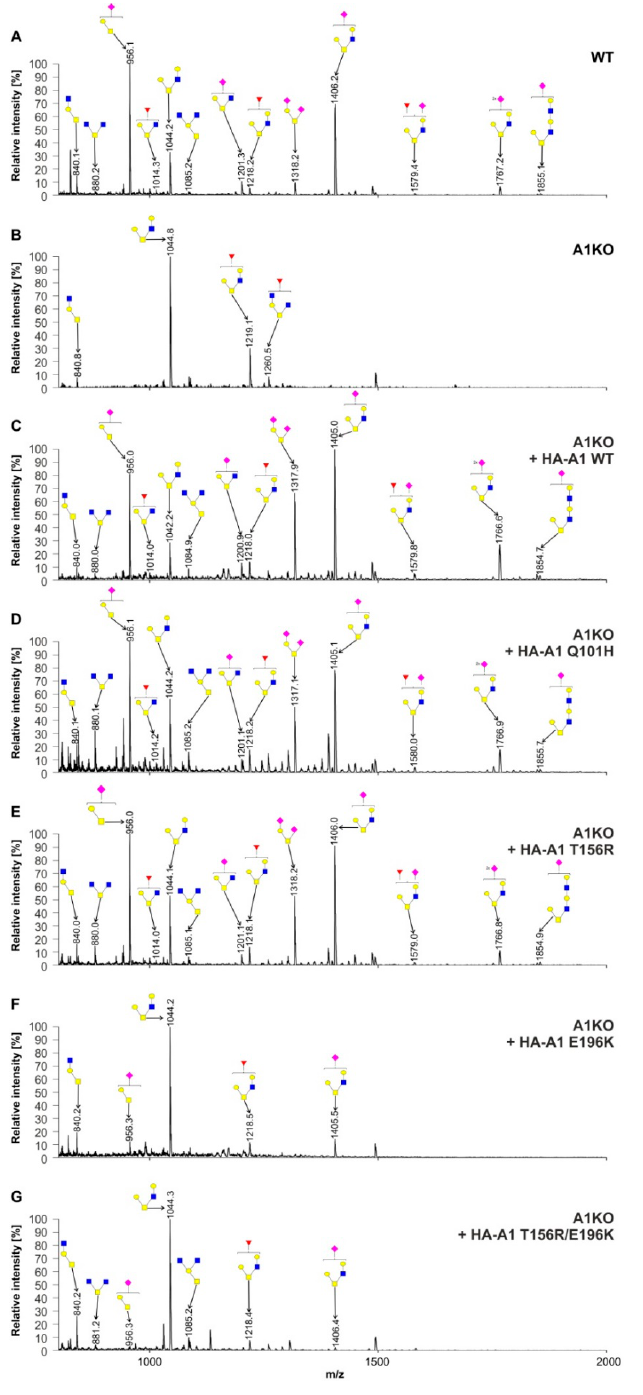
Figure 8. Structural analysis of O-glycans. MALDI-TOF MS characterization of permethylated Bn-O-glycans secreted to culture medium by the wild-type HEK293T cells (WT) ( A ), CST-deficient cells ( B ), CST-deficient cells expressing wild-type CST ( C ), CST-deficient cells expressing the Q101H CST variant ( D ), CST-deficient cells expressing the T156R CST variant ( E ), CST-deficient cells expressing the E196K CST variant ( F ) and CST-deficient cells expressing the T156R/E196K CST variant ( G ). O-Glycan composition was estimated using the GlycoWorkBench tool (2.1; EuroCarbDB). Identified peaks were labeled with mass information and cartoon representations of putative O-glycan chemical structures (based on biosynthetic knowledge). Blue squares, N -acetylglucosamine; yellow squares, N -acetylgalactosamine; yellow circles, galactose; red triangles, fucose; pink diamonds, sialic acid. A1,